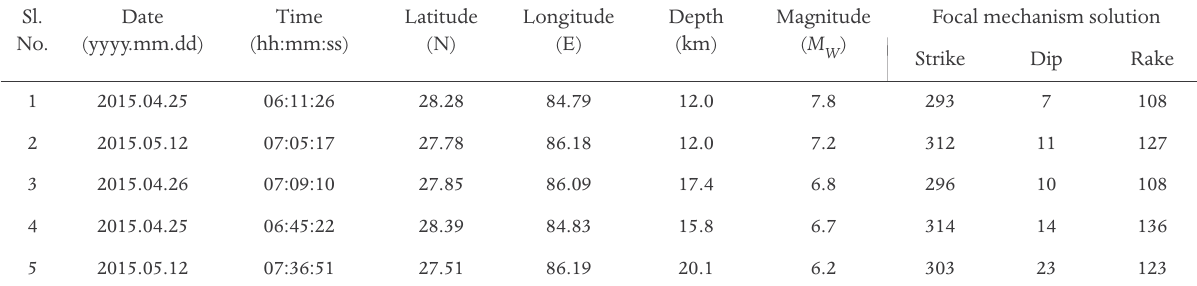
Table 2. Details of the earthquake parameters and focal mechanism solutions of five largest earthquakes occurred in Nepal earthquake se- quence. The information of the focal mechanism solutions are provided by the Global Centroid Moment Tensor (GCMT) database whereas the ISC catalog gives the other parameters of these